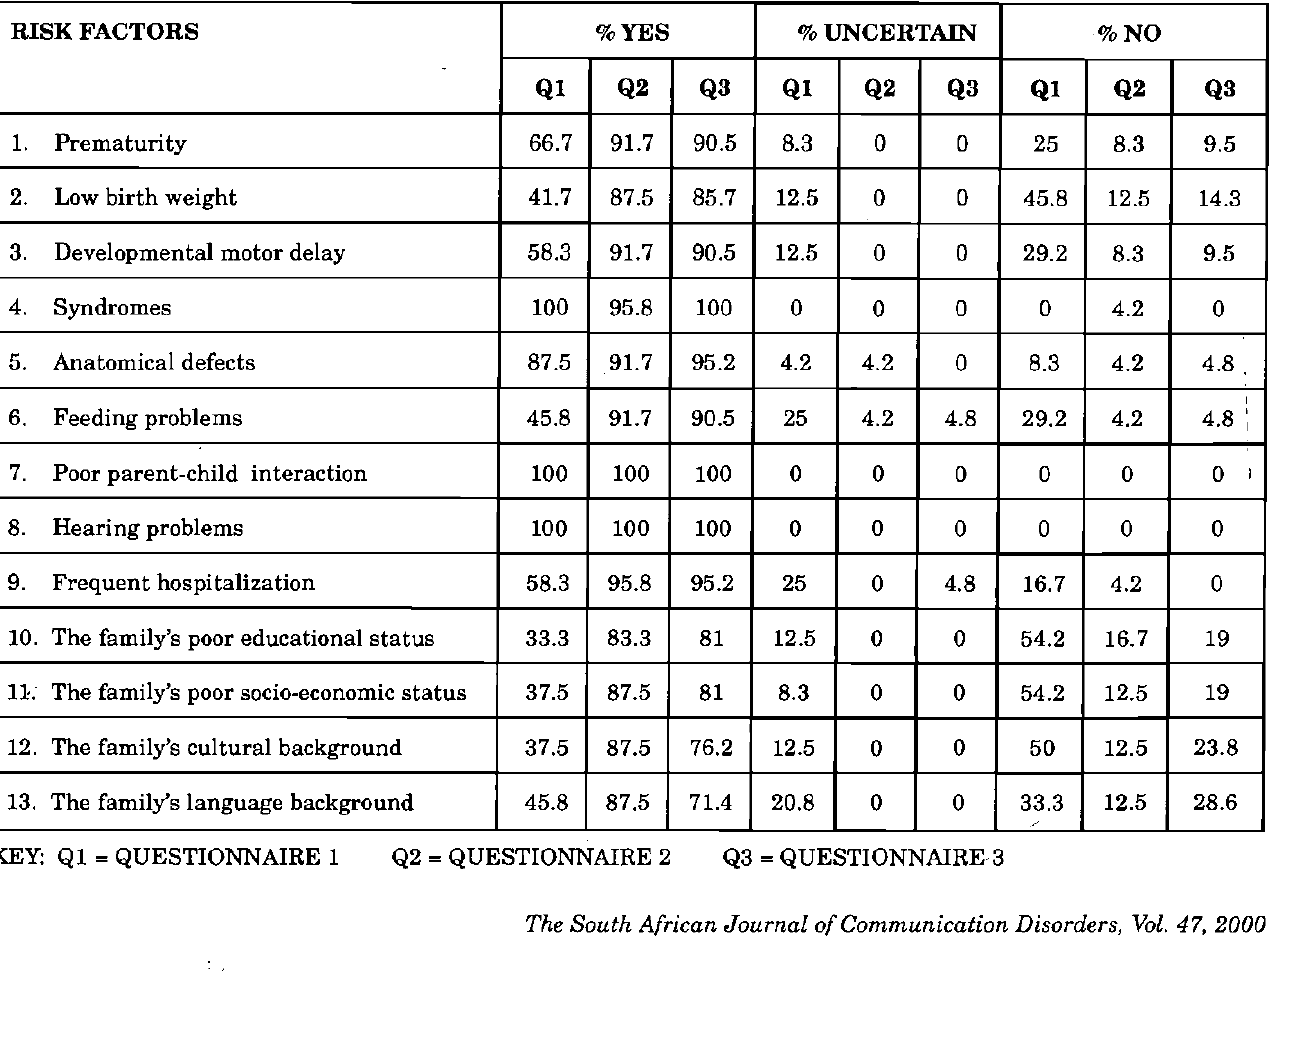
TABLE 8 Community nurses' knowledge of risk factors for communication disorders : (Question D4) RISK